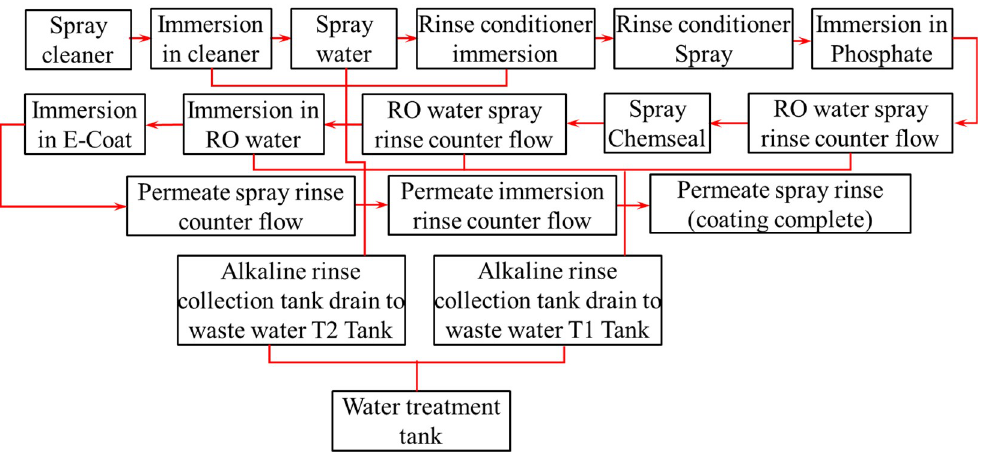
Figure 1. The different steps applied in e-painting process in this study (adapted from Metokote [44]). Note: RO-reverse osmosis.